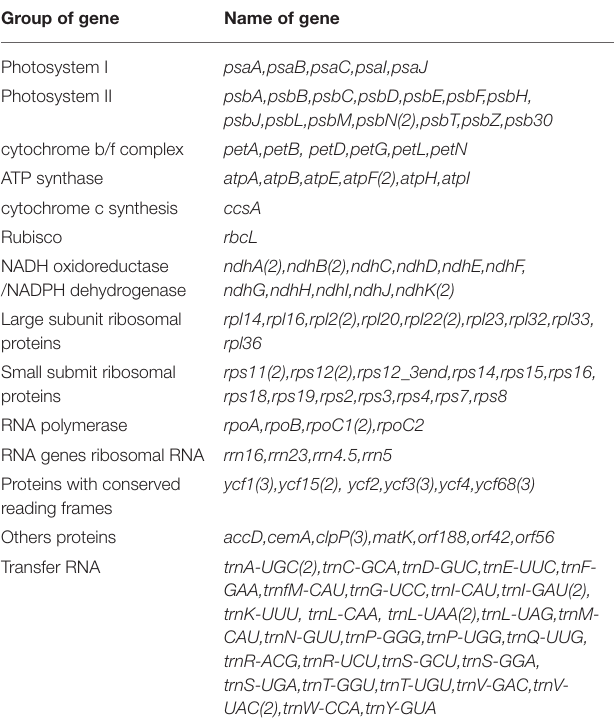
TABLE 1 | Genes identified in the Quillaja saponaria chloroplast genome. Group of